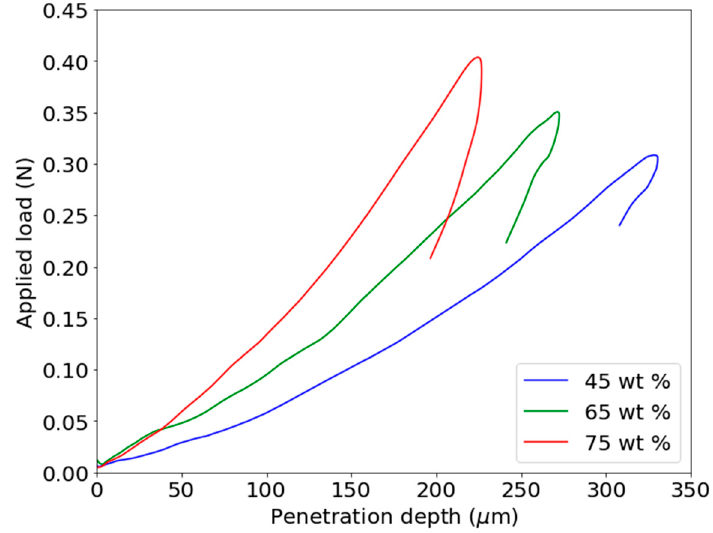
Figure 8. P-h curves of the composites with 45, 65 and 75 wt.% of Fe81Ga19. From these curves the Young’s modulus shown in Table 3 are obtained. Table 3. Young’s modulus of the composites with 45, 65 and 75 wt.% of Fe81Ga19. Weight Fraction